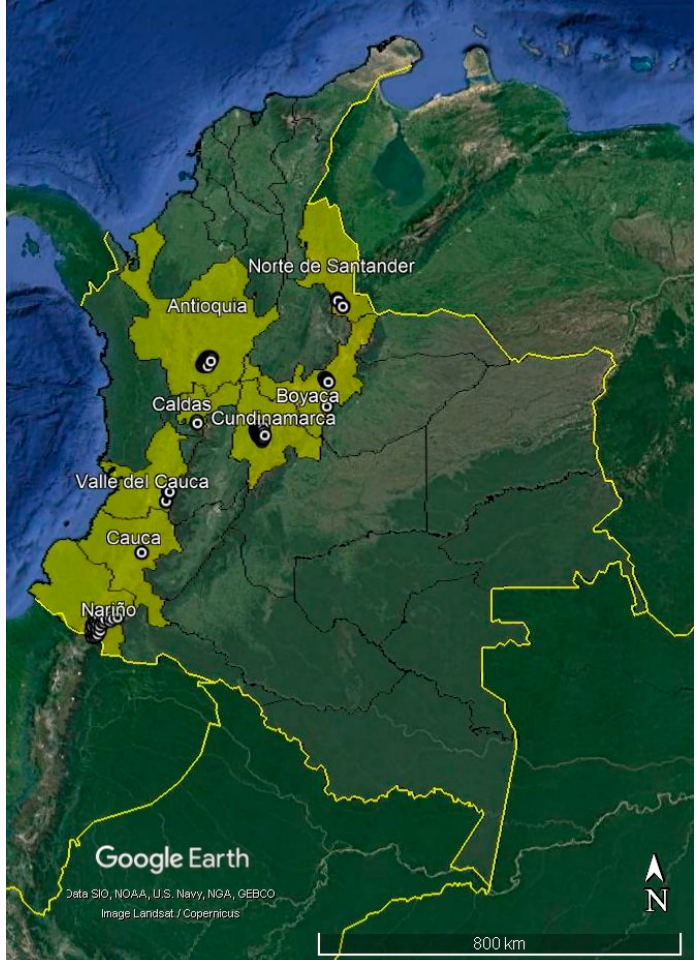
Figure 1. Location of fields surveyed for the presence of Plasmodiophora brassicae in Colombia in 2017. The departments where samples were collected are highlighted in light green with white dots indicating the sampled fields each department.